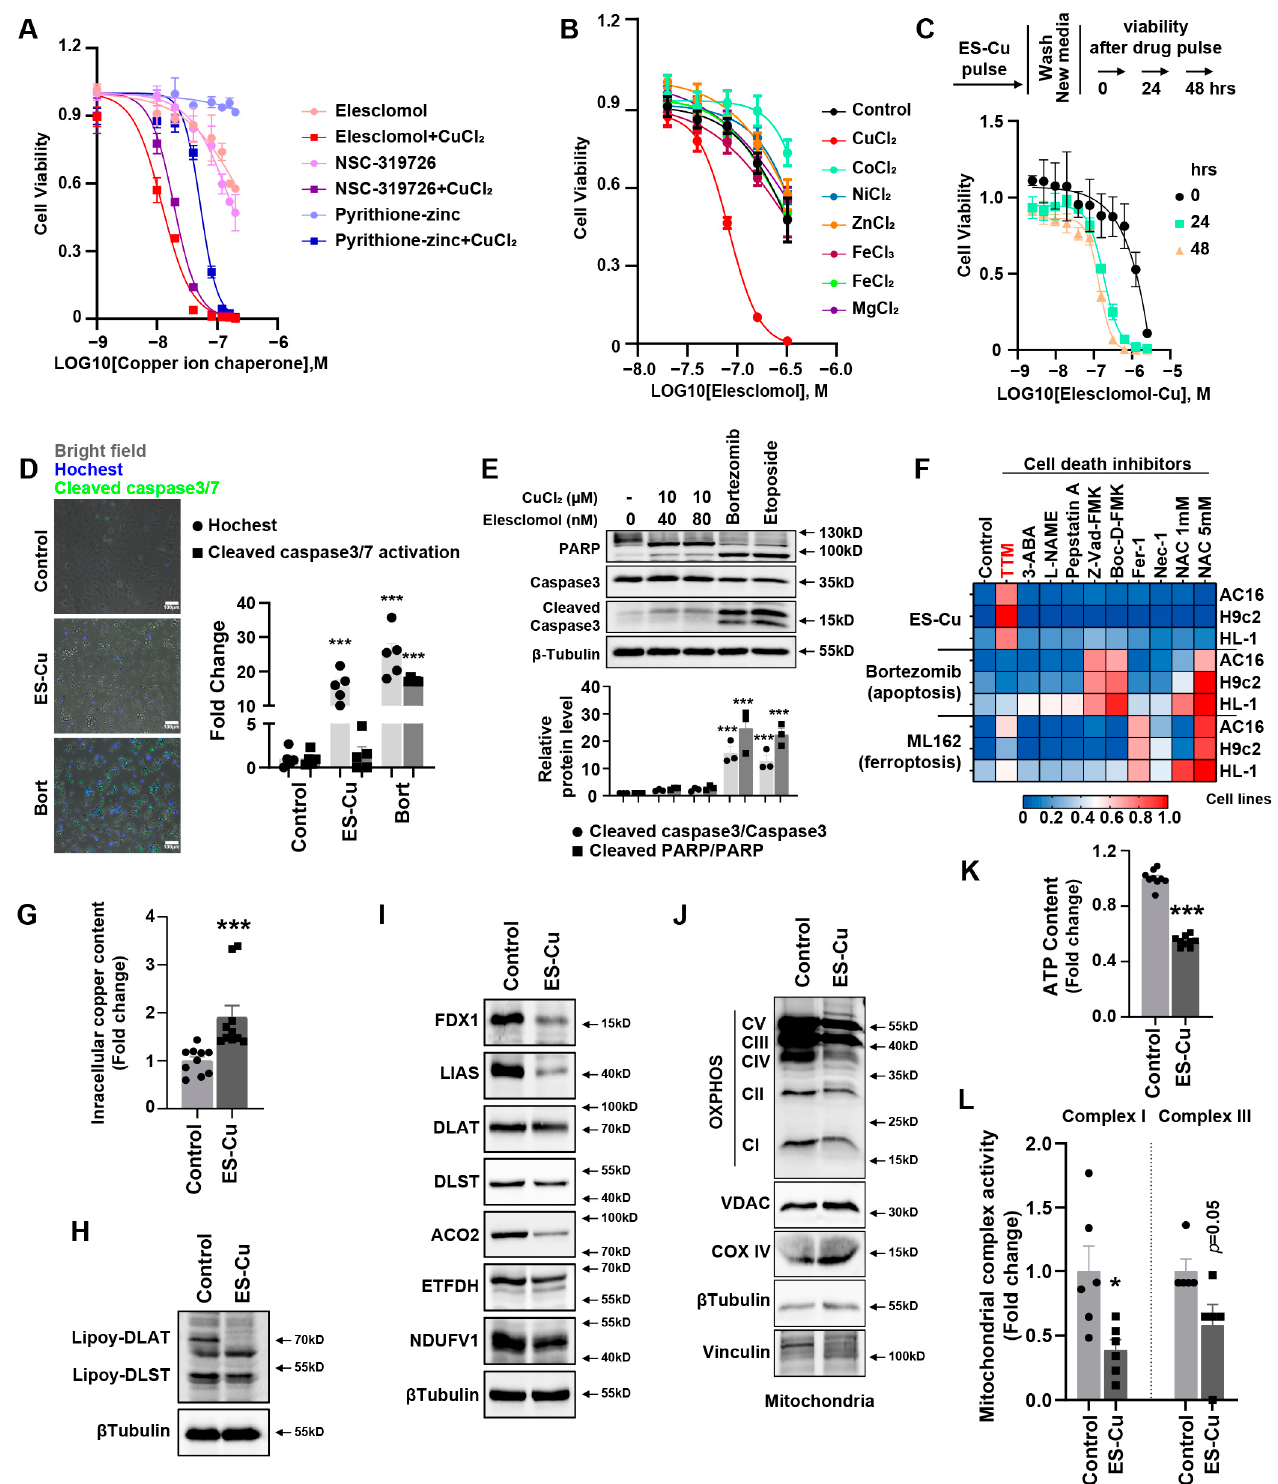
Figure 1. Cuproptosis is non-apoptotic, non-ferroptotic and non-necroptotic in cardiomyocytes. ( A ) Viability of AC16 cells after various treatments indicated copper ion chaperones with or without 10 µ M CuCl 2 . ( B ) Viability of AC16 cells after treatment with elesclomol with or without 10 µ M of indicated metals. ( C ) Viability of AC16 cells was assessed at the indicated times after elesclomol–Cu (1:1 ratio) pulse treatment and growth in fresh media. ( D ) Caspase 3/7 cleavage in AC16 cells after indicated treatments for 24 h (fold change over control). ( E ) Western blot analysis of AC16 cells treated with the indicated concentrations of elesclomol–Cu, 10 μ M bortezomib or 10 μ M etoposide for 24 h. ( F ) Heatmap of viability of AC16, H9c2 and HL-1 cardiomyocytes pretreated with 20 μ M